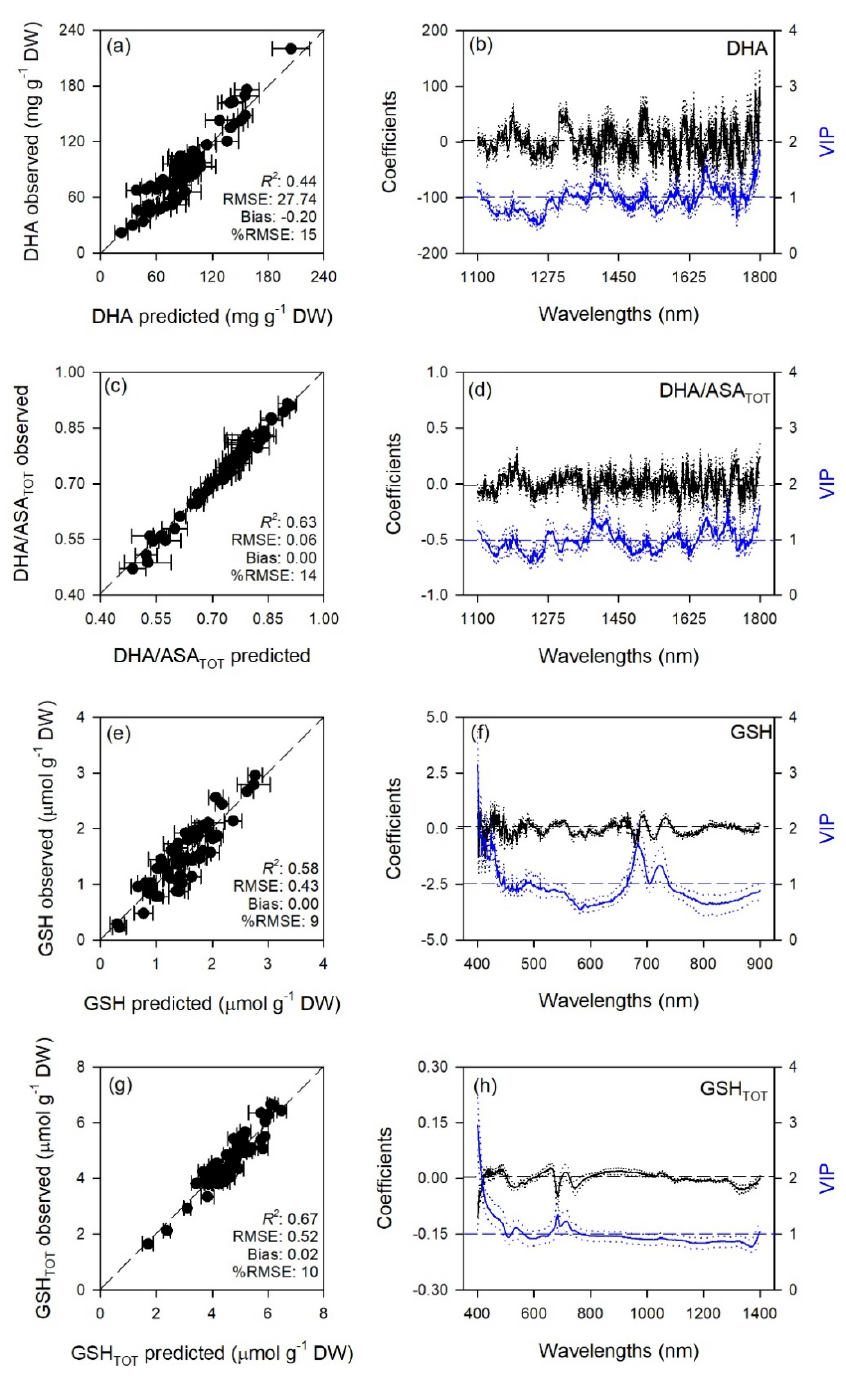
Figure 4. ( a , c , e , g ) Observed versus partial least squares regression (PLSR)-predicted values of oxidized ascorbate (DHA), oxidized:total ascorbate ratio (DHA/ASA TOT ), reduced glutathione (GSH), and total glutathione (GSH TOT ) in sage; error bars for predicted values represent the standard deviations generated from 500 simulated models; dashed line is 1:1 relationship; model goodness-of-fit ( R 2 ), root mean square error (RMSE), bias and %RMSE for validation data generated using 80% of the data for calibration and 20% for validation are reported. ( b , d , f , h ) Mean (solid), 5th and 95th percentile (dotted) of standardized coefficients (black), and variable importance for projection values (VIP, blue) by wavelengths for PLSR-models predicting DHA, DHA/ASA TOT , GSH, and GSH TOT in sage.